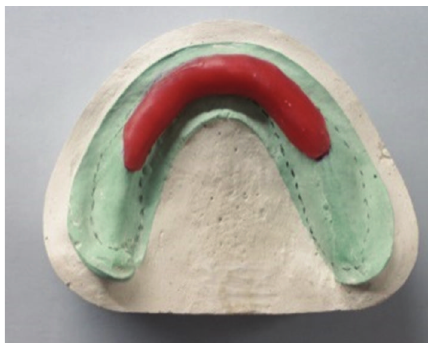
Figure 3: Additional wax placed to create relief over areas of flabby tissues.